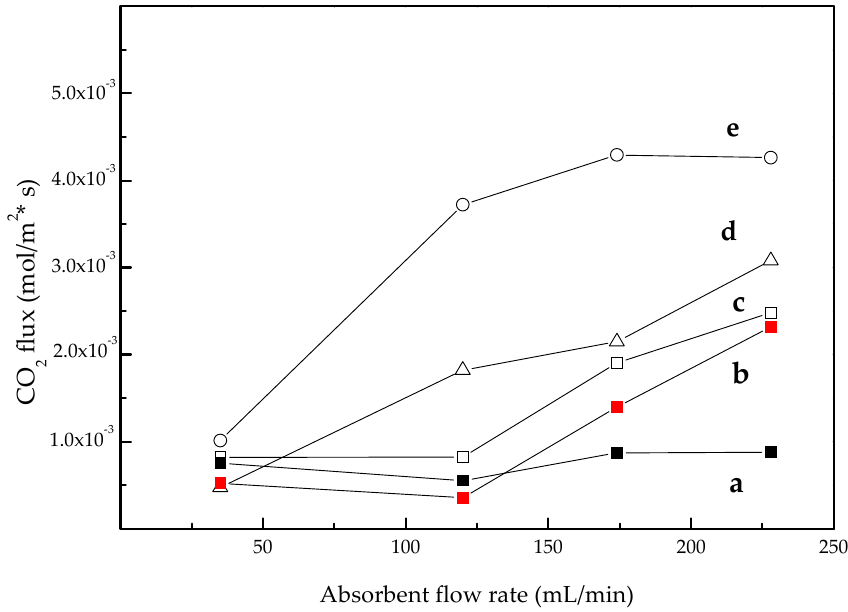
Figure 7. CO 2 absorption flux into L0–L20 membranes as a function of liquid absorbent flow rate. ( a ) L20; ( b ) L10; ( c ) L0; ( d ) L2; ( e ) L5.